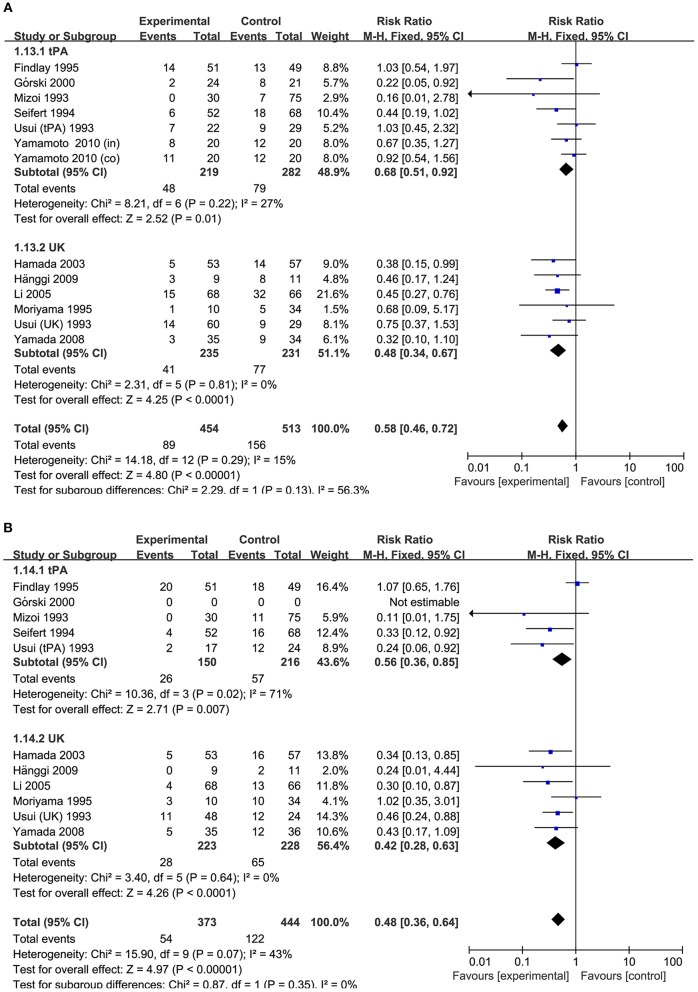
Meta-analysis of associations between intracisternal fibrinolysis and the risk of poor neurologic recovery (A) or the incidence of DIND (B) in patients with aSAH (stratified by types of thrombolytic agents). aSAH, aneurysmal subarachnoid hemorrhage; CI, confidence interval; M–H, Mantel–Haenszel method; UK, urokinase; tPA, tissue plasminogen activator.